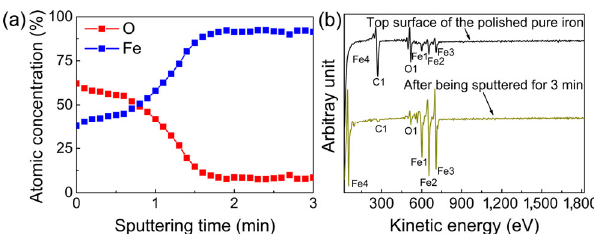
Fig. 5 (a) AES depth profiles of the oxide film formed on the top surface of pure iron after being polished with the H 2 O 2 -based acidic slurry. (b) Corresponding AES spectra before and after sputtering for 3 min.